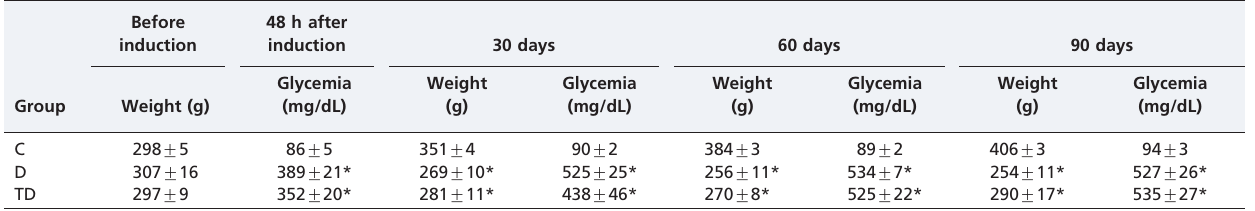
Table 1 - Body weight and blood glucose in the studied groups. Before